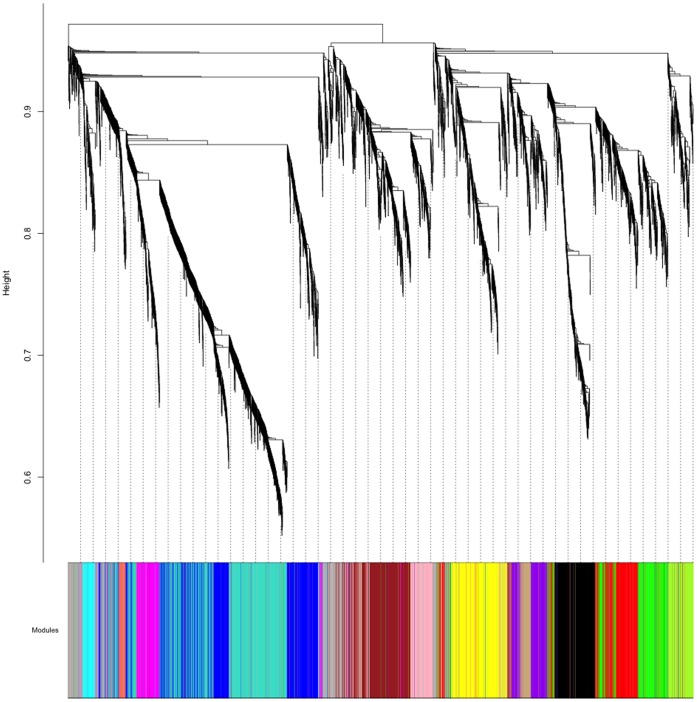
Network construction identifies distinct modules of co-expressed genes.The network was constructed using gene expression data of 92 medicated schizophrenia cases and 78 controls (dataset 1). The dendrogram was produced by average linkage hierarchical clustering of genes using 1-topological overlap as dissimilarity measure (see methods section). Modules of co-expressed genes were assigned colors corresponding to the branches indicated by the horizontal bar beneath the dendrogram.